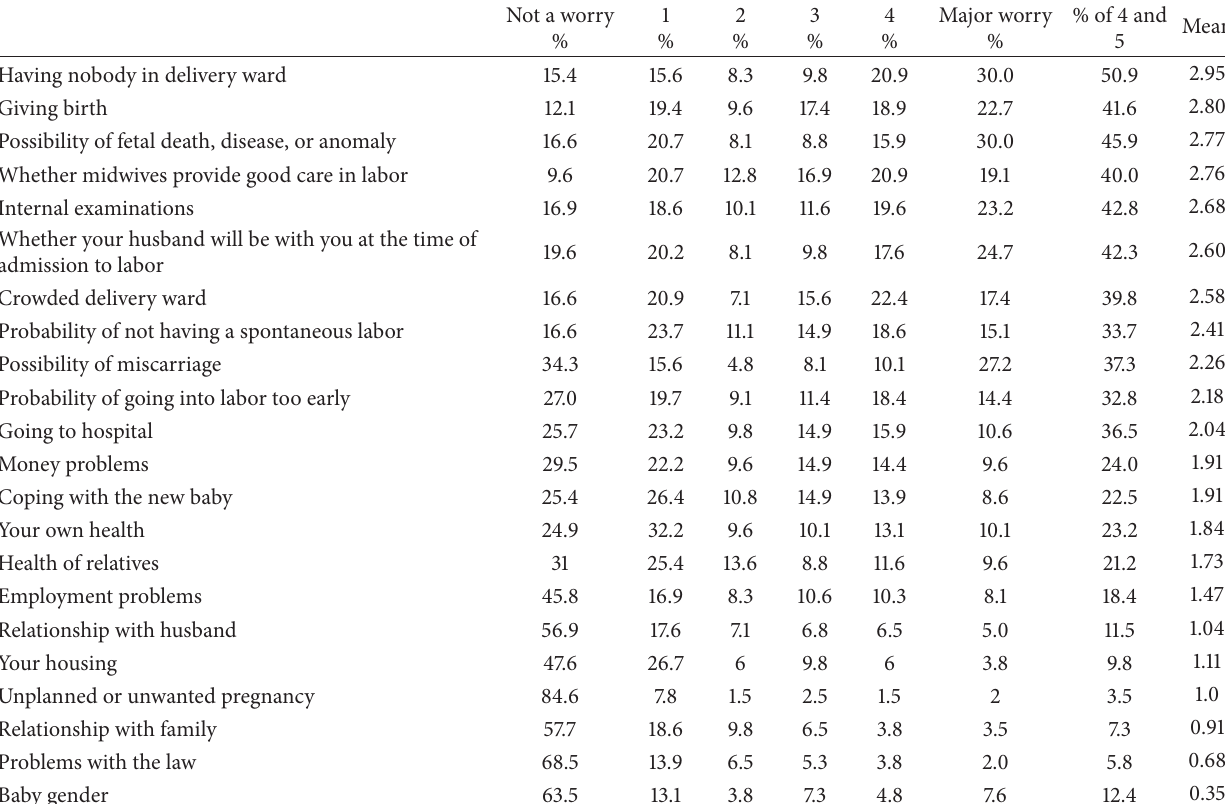
Table 2: Descriptive parameters of the Farsi Cambridge Worry